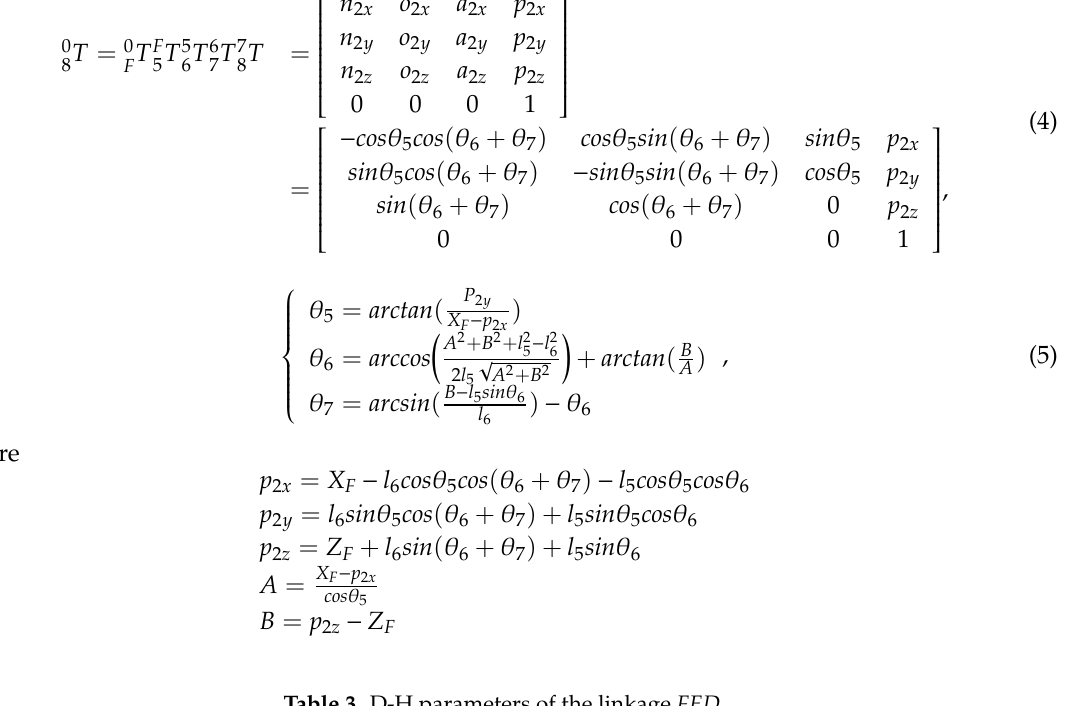
Table 3. D-H parameters of the linkage